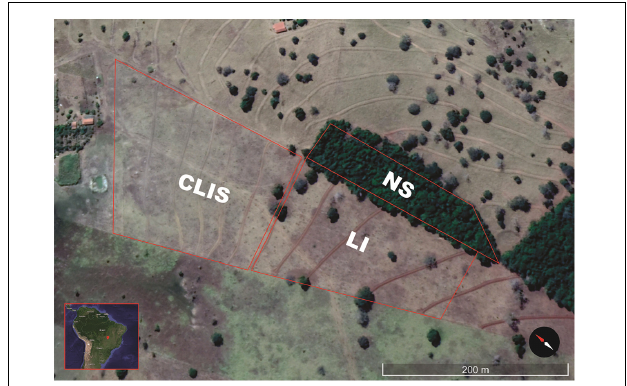
FIGURE 1 | Image of UEPE Boa Esperança, Iporá, Goiás, Brazil, in June of 2018. The demarcated fields represent the treatments: NS - native savanna, LI - low-input recovering, and CLIS - crop-livestock integrated system.